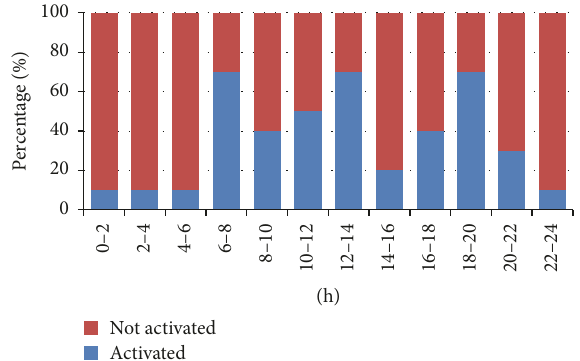
Figure 3: Timetable for the low-power consumption strategy. In blue, the estimated percentage of time that pedestrian crossings are typically used by people. In red, the estimated percentage of time that pedestrian crossings are not used by people.